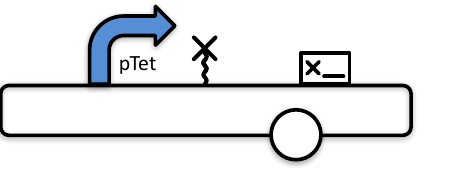
Figure 33: Promoter stored in a plasmid as in Figure 30, except that there is a ribonuclease site after the promoter rather than restriction sites flanking it.